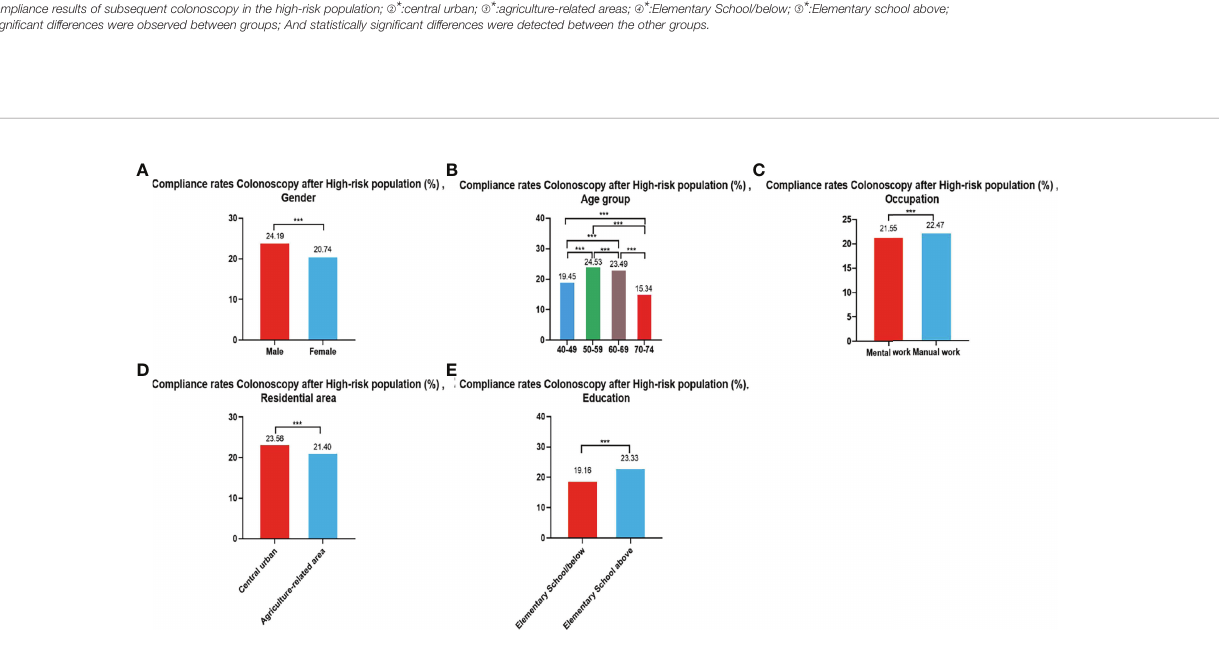
TABLE 6 | Analysis of compliance results of subsequent colonoscopy in the high-risk population, (n,%). Year High-risk Colonoscopy ① * population (%)